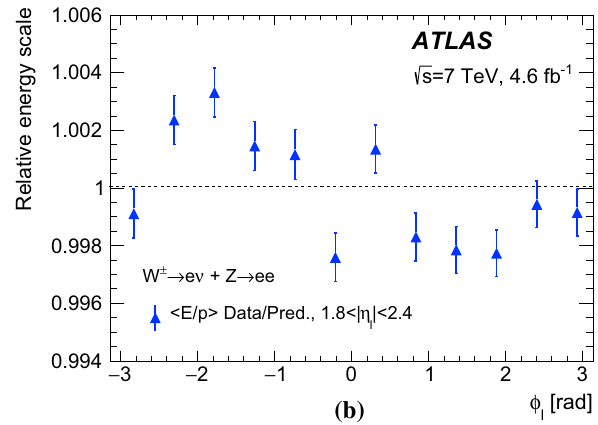
the track p is corrected for the momentum scale, resolution and sagitta bias. The mean for the E / p distribution integrated in φ is normalised to unity. The error bars are statistical only